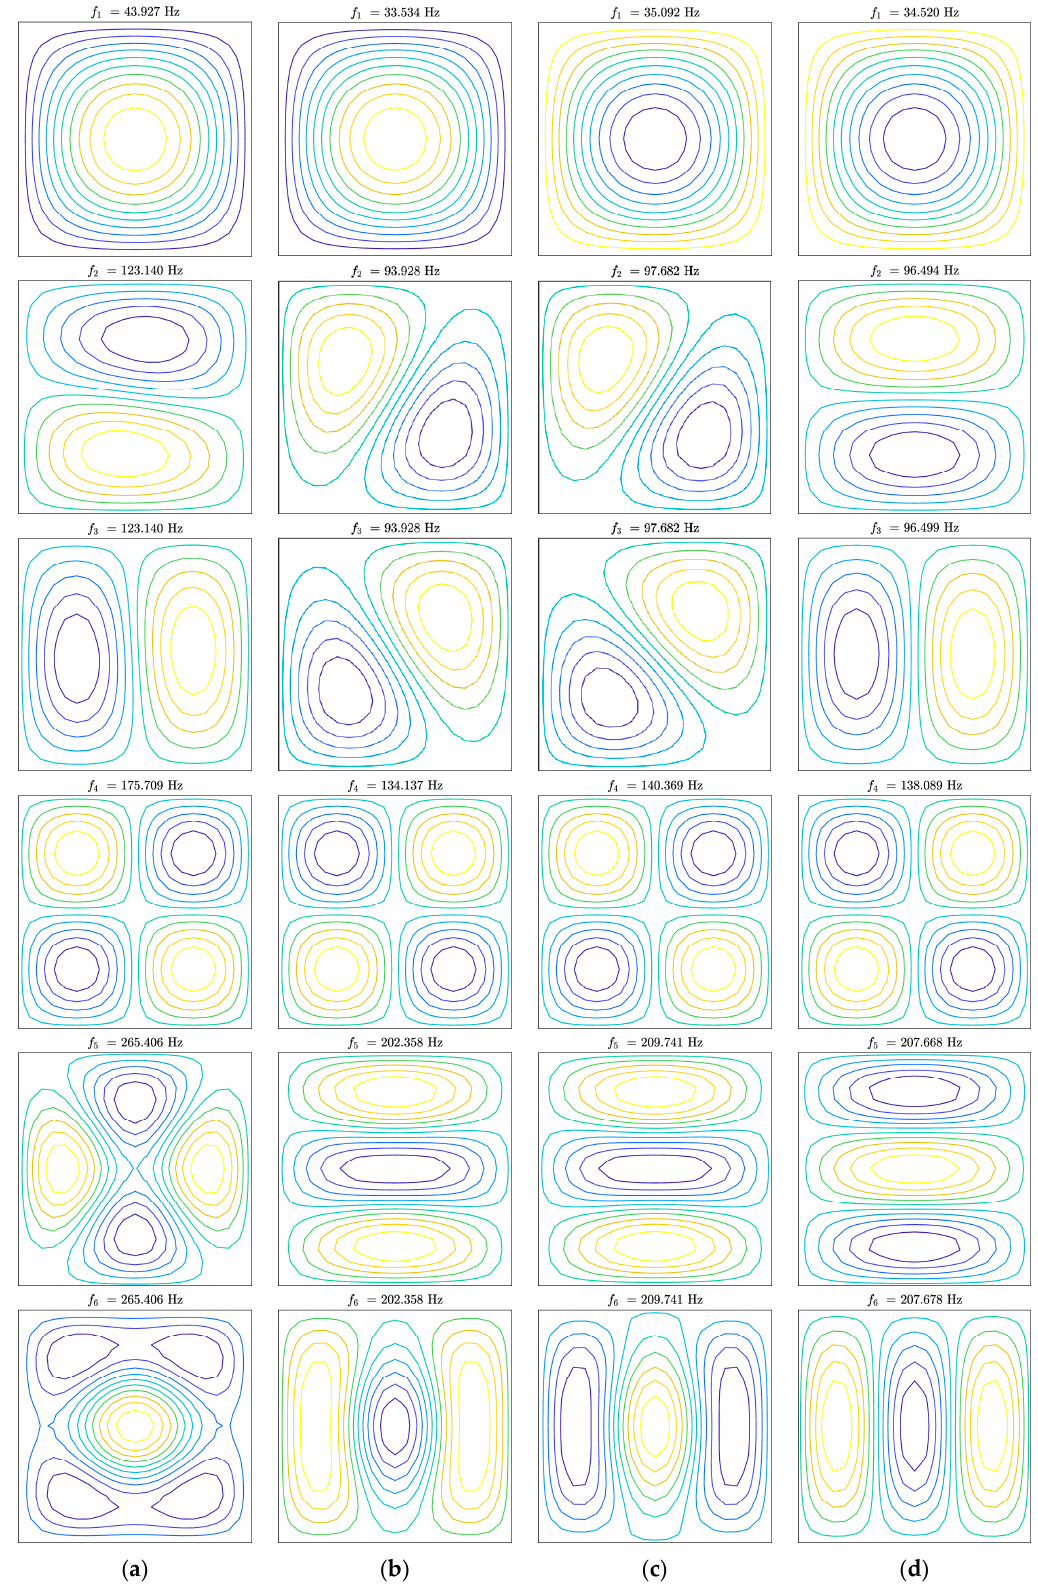
Figure 5. First six mode shapes for a simply-supported laminated thin plate with different fiber distributions: ( a ) Scheme 1 (uniform); ( b ) Scheme 2; ( c ) Scheme 3; ( d ) Scheme 4.